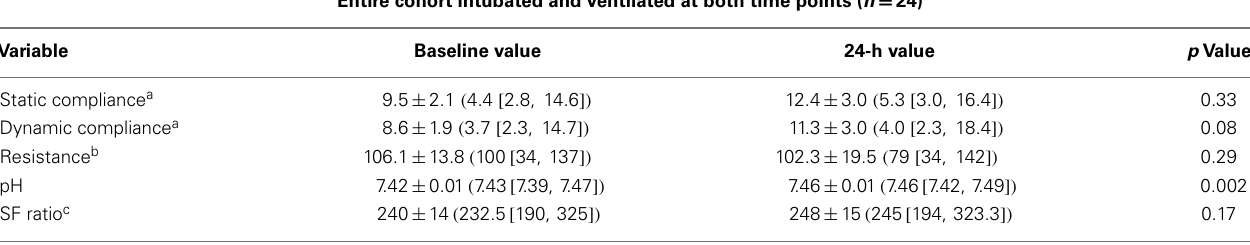
Table 4 |Assessment of pulmonary variables before and after 24h of aminophylline . Entire cohort intubated and ventilated at both time points ( n =